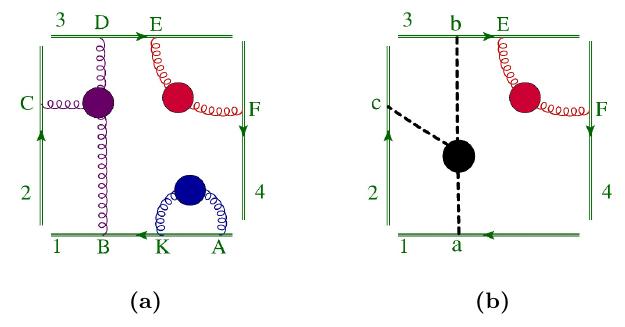
(1 , 1 , 2 , 3) and its 4 , I